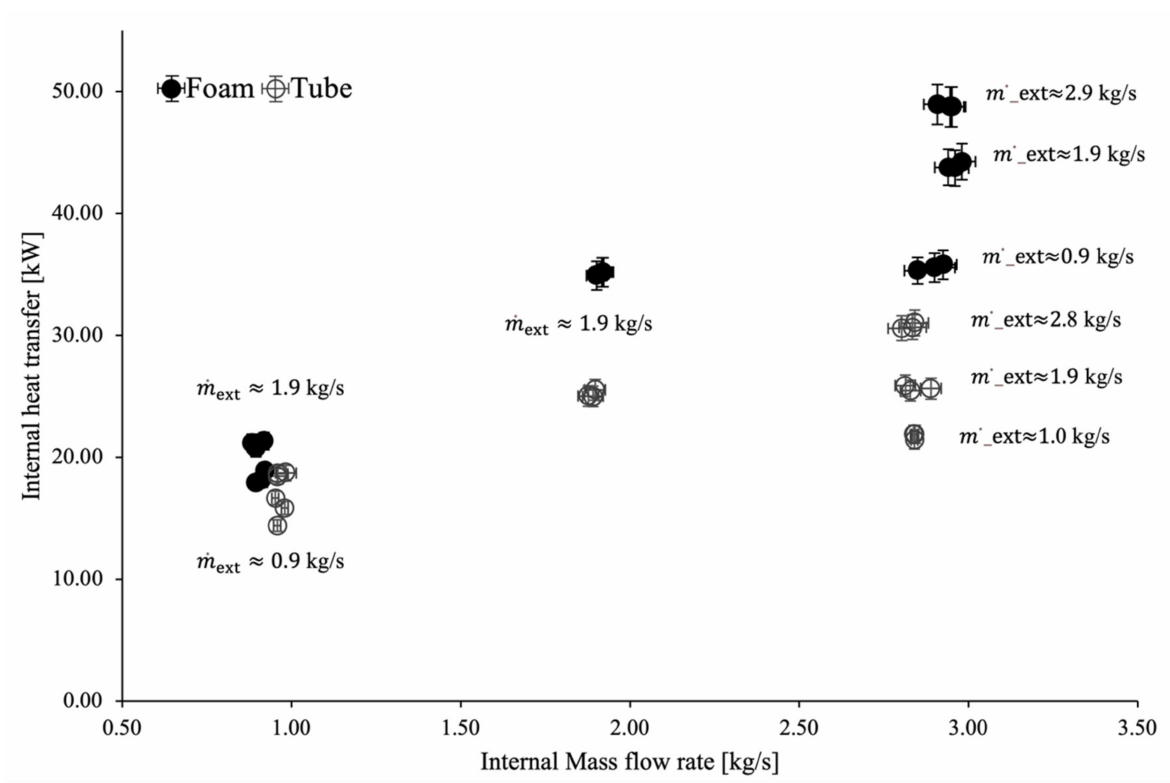
Figure 4. Internal heat transfer plotted versus the internal mass flow rate. (The external mass flow rates are shown next to each data set).